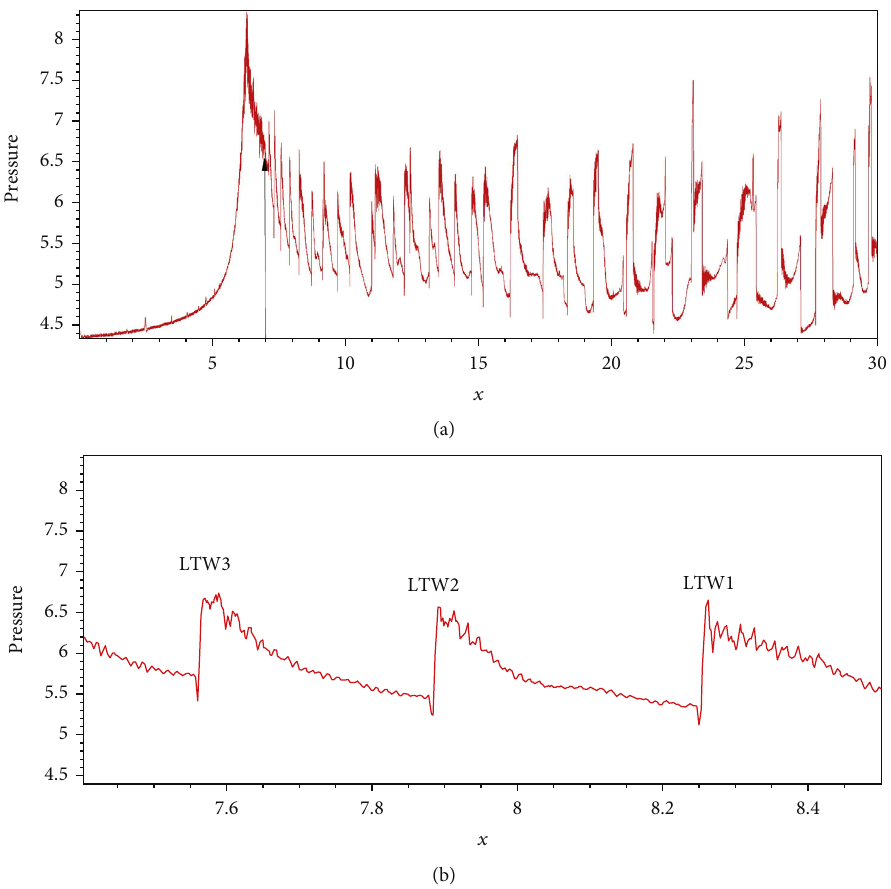
Figure 8: Pressure distribution along the leading shock at t = 15 . (a) 0 < x < 30 and (b) 7 : 5 < x < 8 : 5